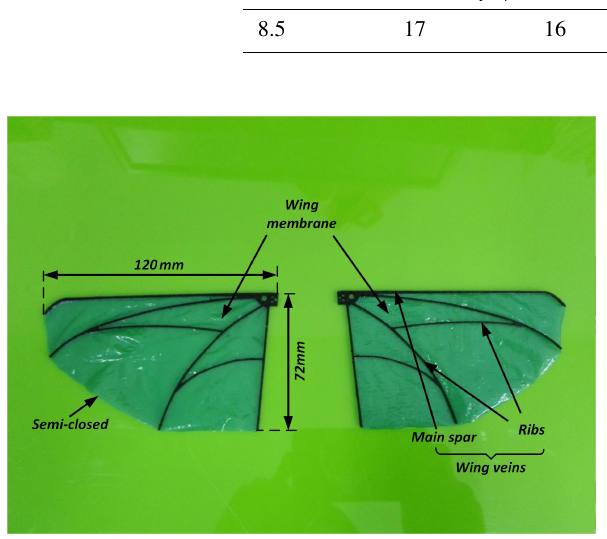
Figure 7. Layout of wing veins and shape of